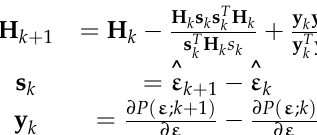
It is clear that the proposed algorithm is contained in the second part.